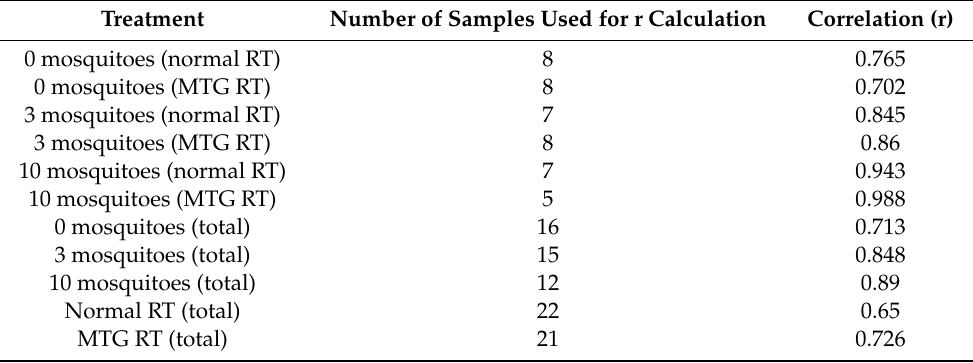
Table 1. Correlation between dilution factor and target quantification according to treatment. Treatment